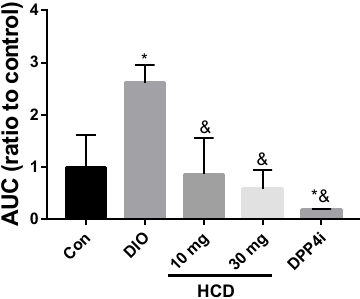
Figure 5. Insulin tolerance of DIO mice after selected natural compound gavaging . DIO mice were fed with HCD and Sitagliptin ( DPP4i ) and then insulin tolerance measured through OGTT . Results were shown as mean ± SEM from 6 individuals * p < 0.05 represented as significantly different compared with normal mice ( Con ) , and & p < 0.05 represented as significantly different from DIO mice .